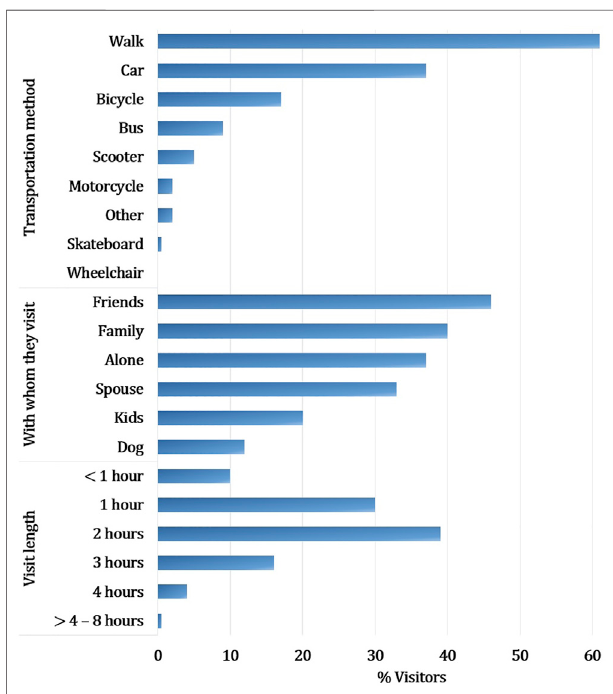
FIGURE 4 | Characteristics of urban nature site visits by transportation method, with whom they visited, and visit length by percentage of visitors.